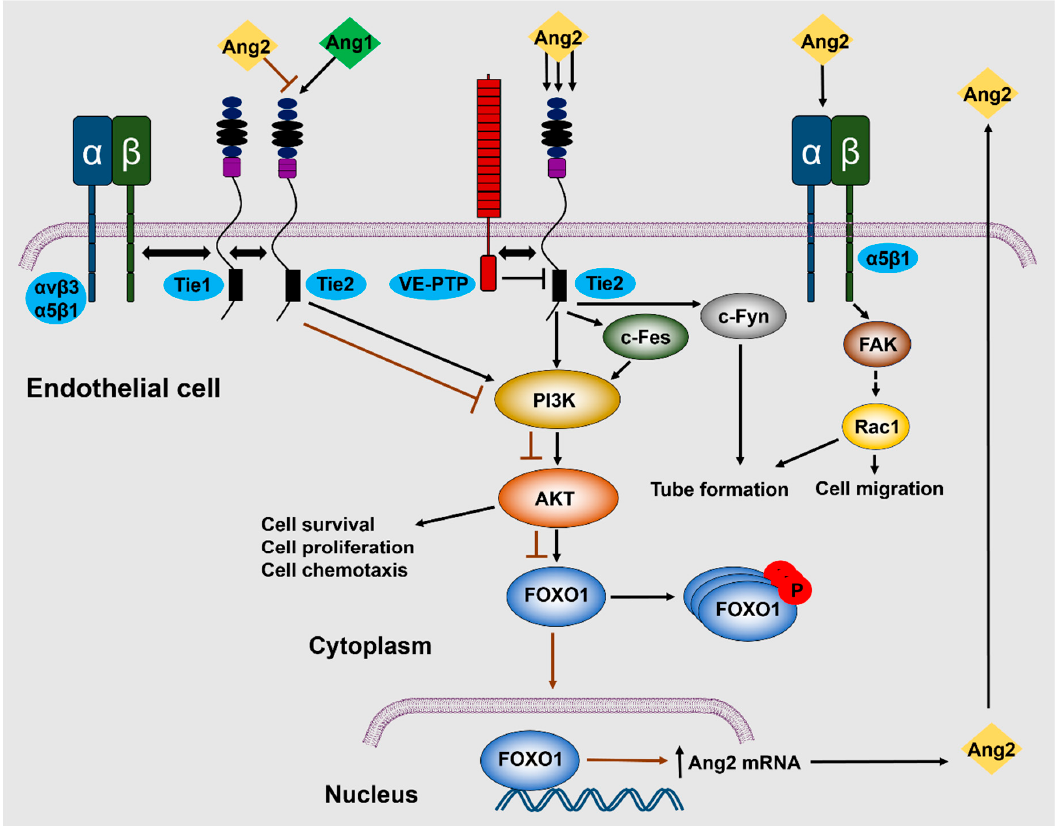
Figure 2. Illustration of the main signaling pathways activated upon Ang2 binding to endothelial cells. Ang2 can interact with Tie2 either as an antagonist or as an agonist, when present at high concentrations. Activation of the Tie2 downstream pathway, which occurs in the absence of VE-PTP, eventually leads to Foxo1 inhibition and upregulation of endothelial functions. Upon Ang2 binding, Tie2 heterodimerizes with Tie1 and they can both form complexes with integrins. Ang2 can bind to integrins also independently of Tie2, inducing endothelial cell migration and sprout formation.